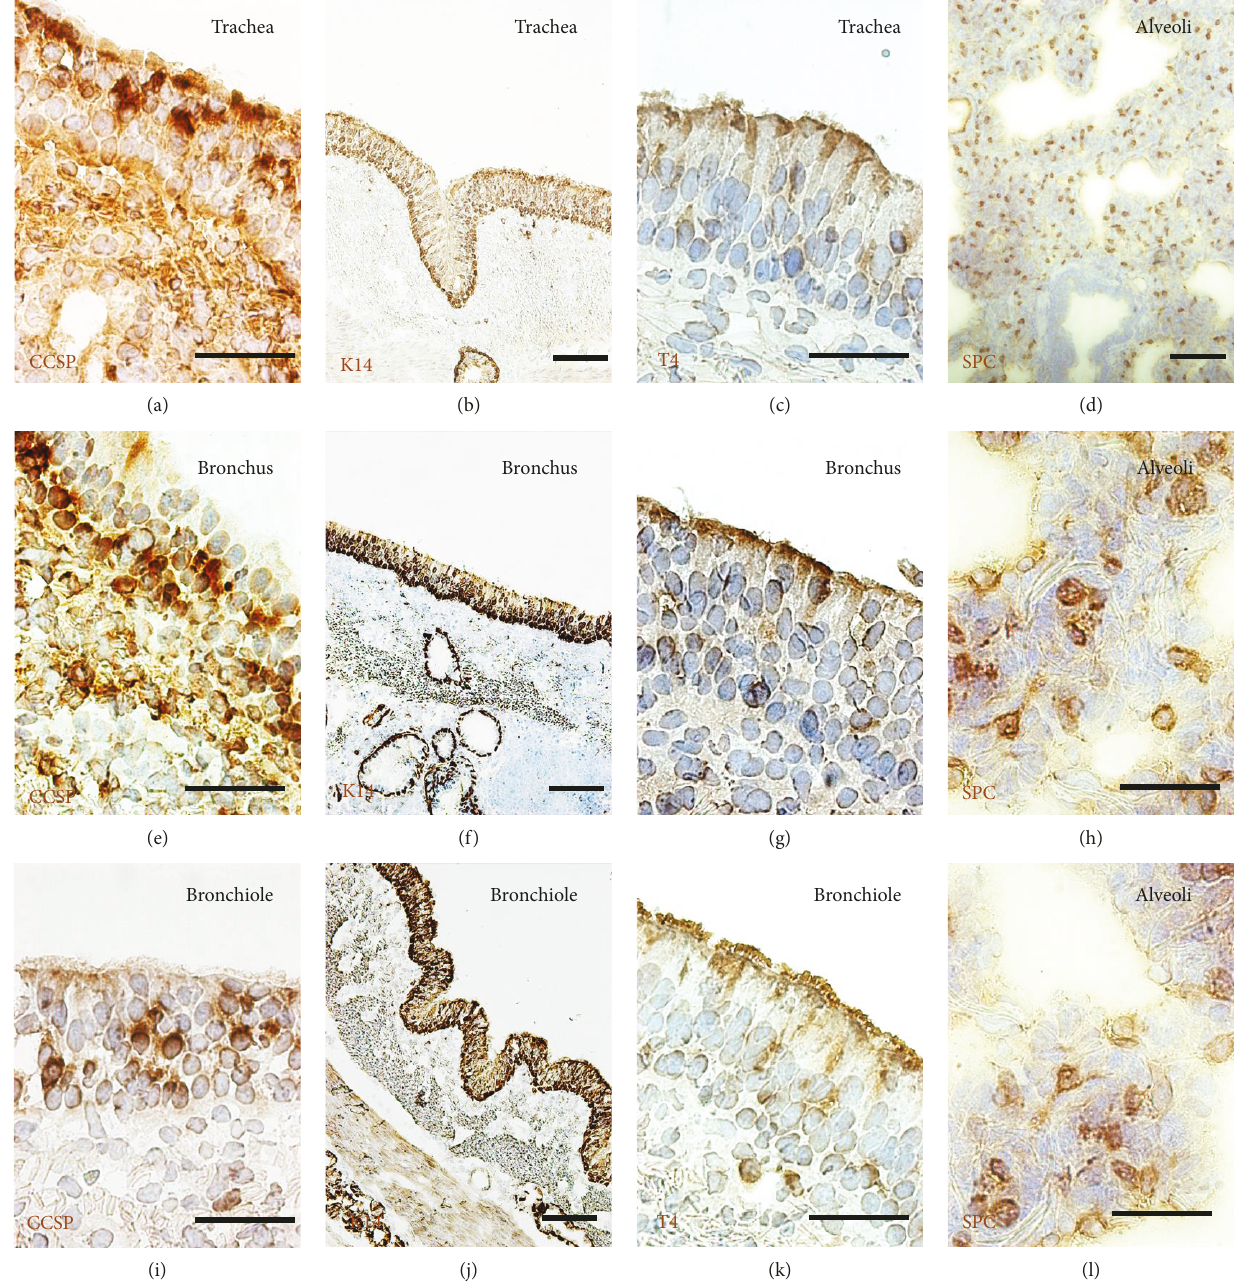
Figure 2: Composition of epithelial cell types in conducting airway epithelium of an adult porcine lung. Representative images of immunohistochemistry (IHC) staining with epithelial cell-speci fi c markers were used for the identi fi cation of epithelial cell types of an adult porcine lung. (a, e, i) Immunohistochemistry staining of CCSP (brown) revealed that infrequent club cells are distributed in the region of the trachea, bronchus, and bronchiole. (b, f, j) Immunohistochemistry staining of K14 (brown) showed that basal cells are distributed in the region of the trachea, bronchus, and bronchiole. (c, g, k) Immunohistochemistry staining of T4 (brown) showed that ciliated cells are tapered along the tracheal-bronchial airway axis. (d, h, l) Immunohistochemistry staining of SPC (brown) showed the alveolar type 2 (AT2) cells in the alveoli region of a distal lung, counterstained with hematoxylin (blue). Bar=50 or 100 μ